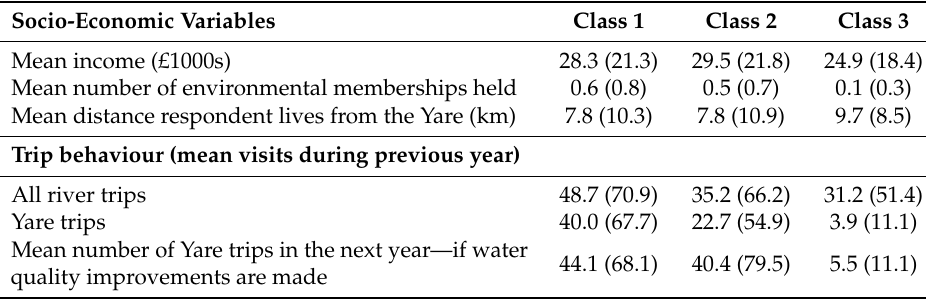
Table 4. Post-estimation results for the latent class